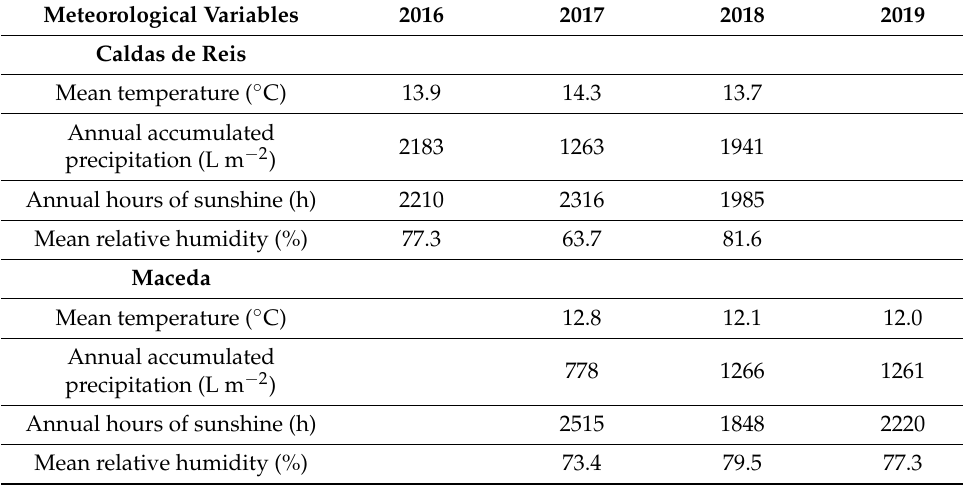
Table 2. Meteorological variables in Caldas de Reis and Maceda during the study period. Weather variables were calculated from monthly data (www.meteogalicia.gal, accessed on 3 August 2022) from the observations recorded at the weather stations located in ‘Caldas de Reis’ for Caldas de Reis plot and ‘Monte Medo’ for Maceda